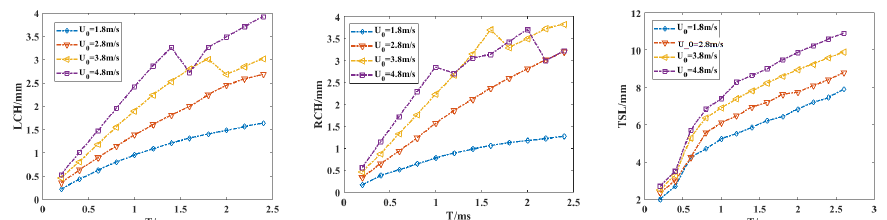
Figure 19. Crown heights at different impact velocities when θ = 30 ◦